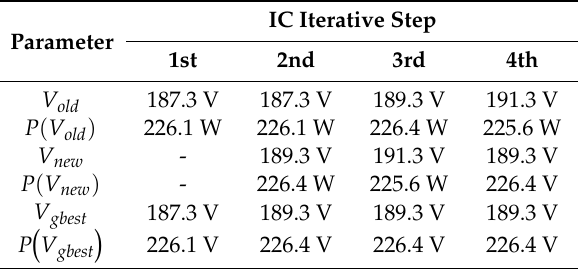
Table 2. Tracking steps details using IC.